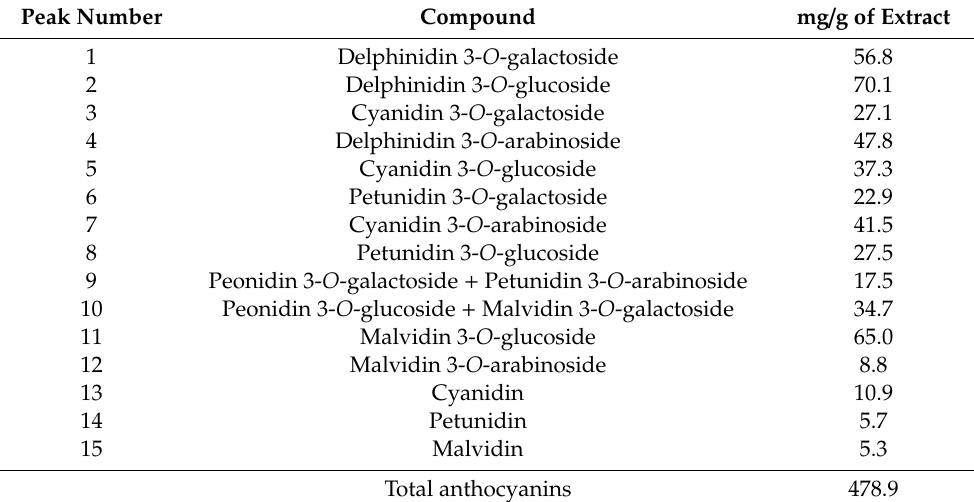
Table 1. Content of anthocyanins in the lyophilised bilberry extract expressed as mg/g (delphinidin 3 ‐ O ‐ glucoside equivalents) of dry extract.